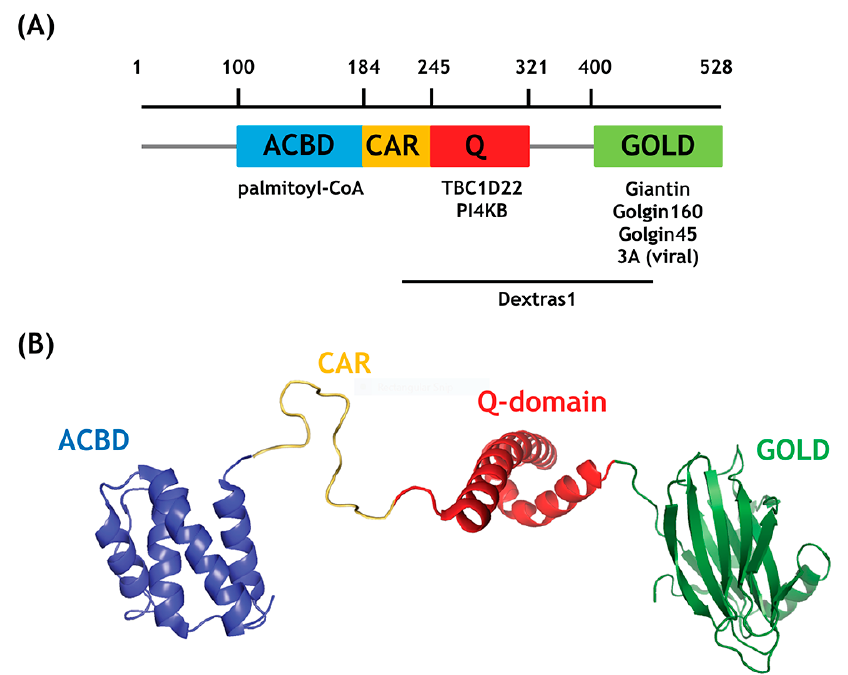
Figure 1. ( A ) Schematic representation of the acyl-CoA-binding domain-containing 3 (ACBD3) domain structure with known binding sites. (ACBD: acyl-CoA binding domain; CAR: charged amino acid region; Q: glutamine-rich domain) ( B ) Pseudoatomic model of ACBD3, based on previously published GOLD (PDB code: 5TDQ) and Q domain (PDB code: 2N72) structures plus a homologous ACBD domain crystal structure from bovine ACBD1 (PDB code: 1ACA), which binds palmitoyl-CoA directly [10,22]. Crystal structure of full length ACBD3 and its ACBD domain are currently not available.